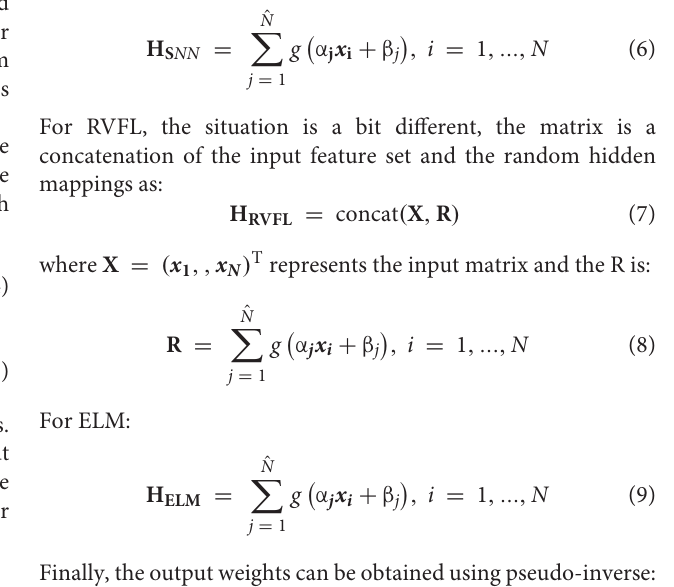
our PBTNet. The structures of the three RNNs are presented in